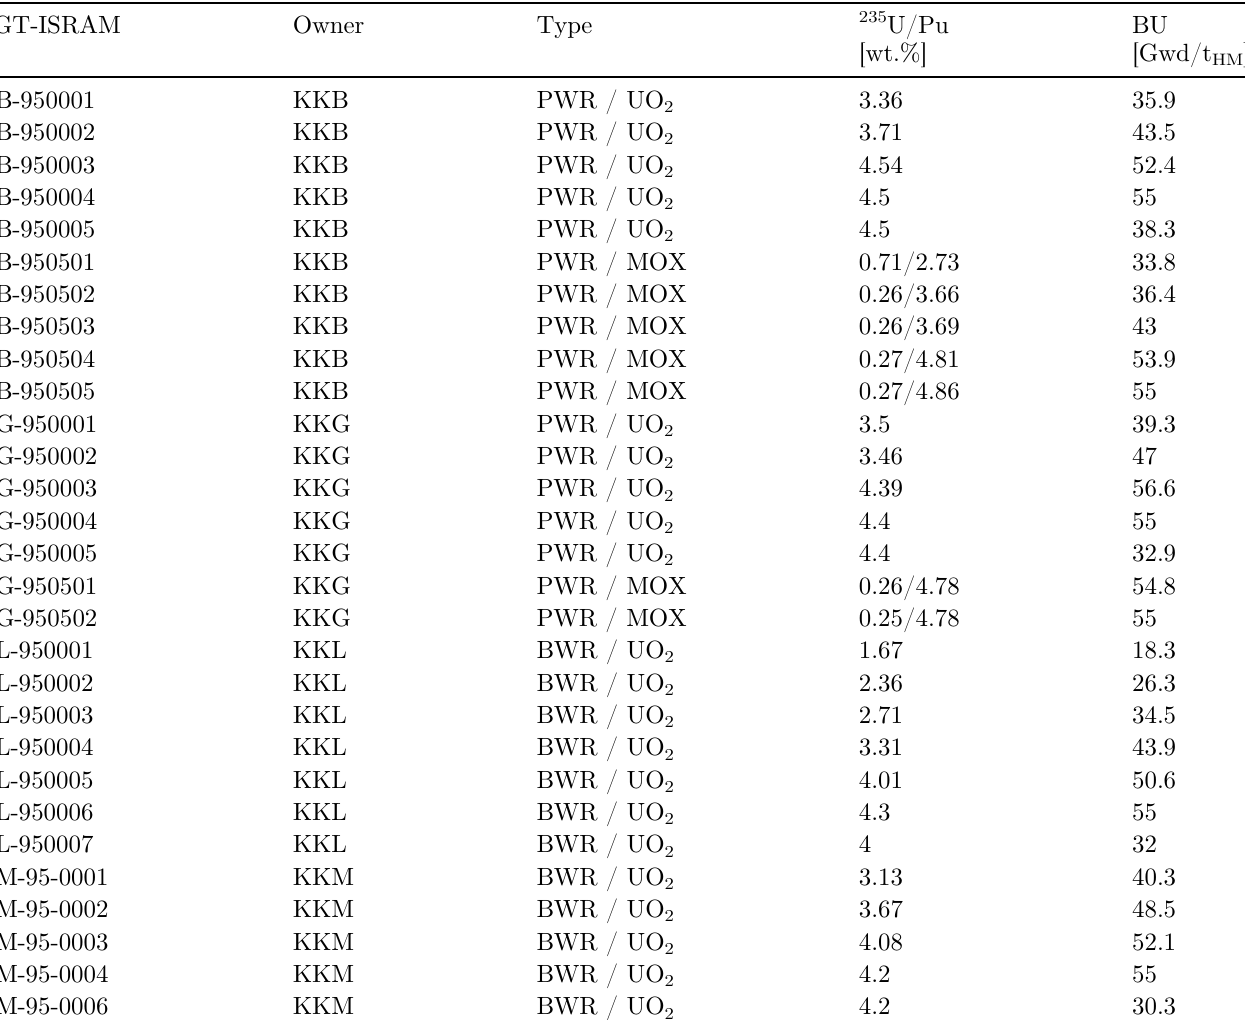
Table 1. FA (fuel assembly) categorization per NPP, fuel type, average initial enrichment and average burnup to be considered for the